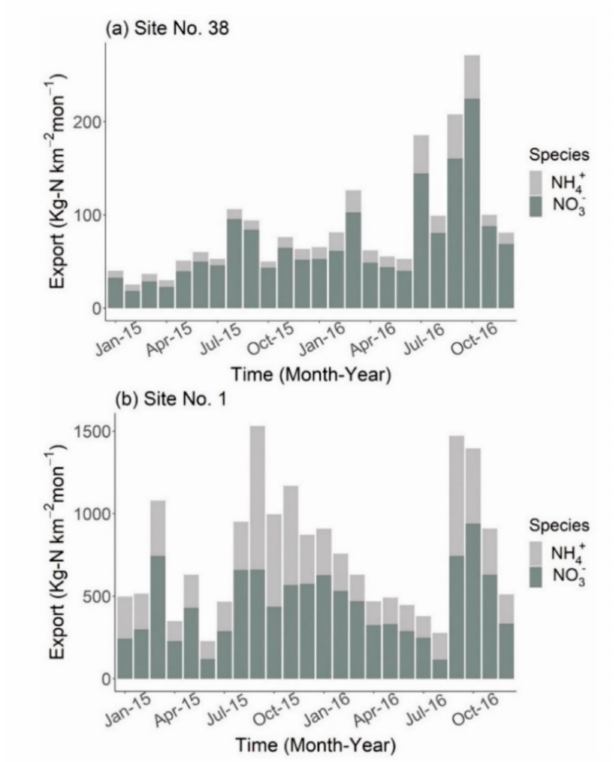
Figure 4. The monthly NO 3 − and NH 4 + exports in site no. 38 ( a ) and no. 1 ( b ) during the study